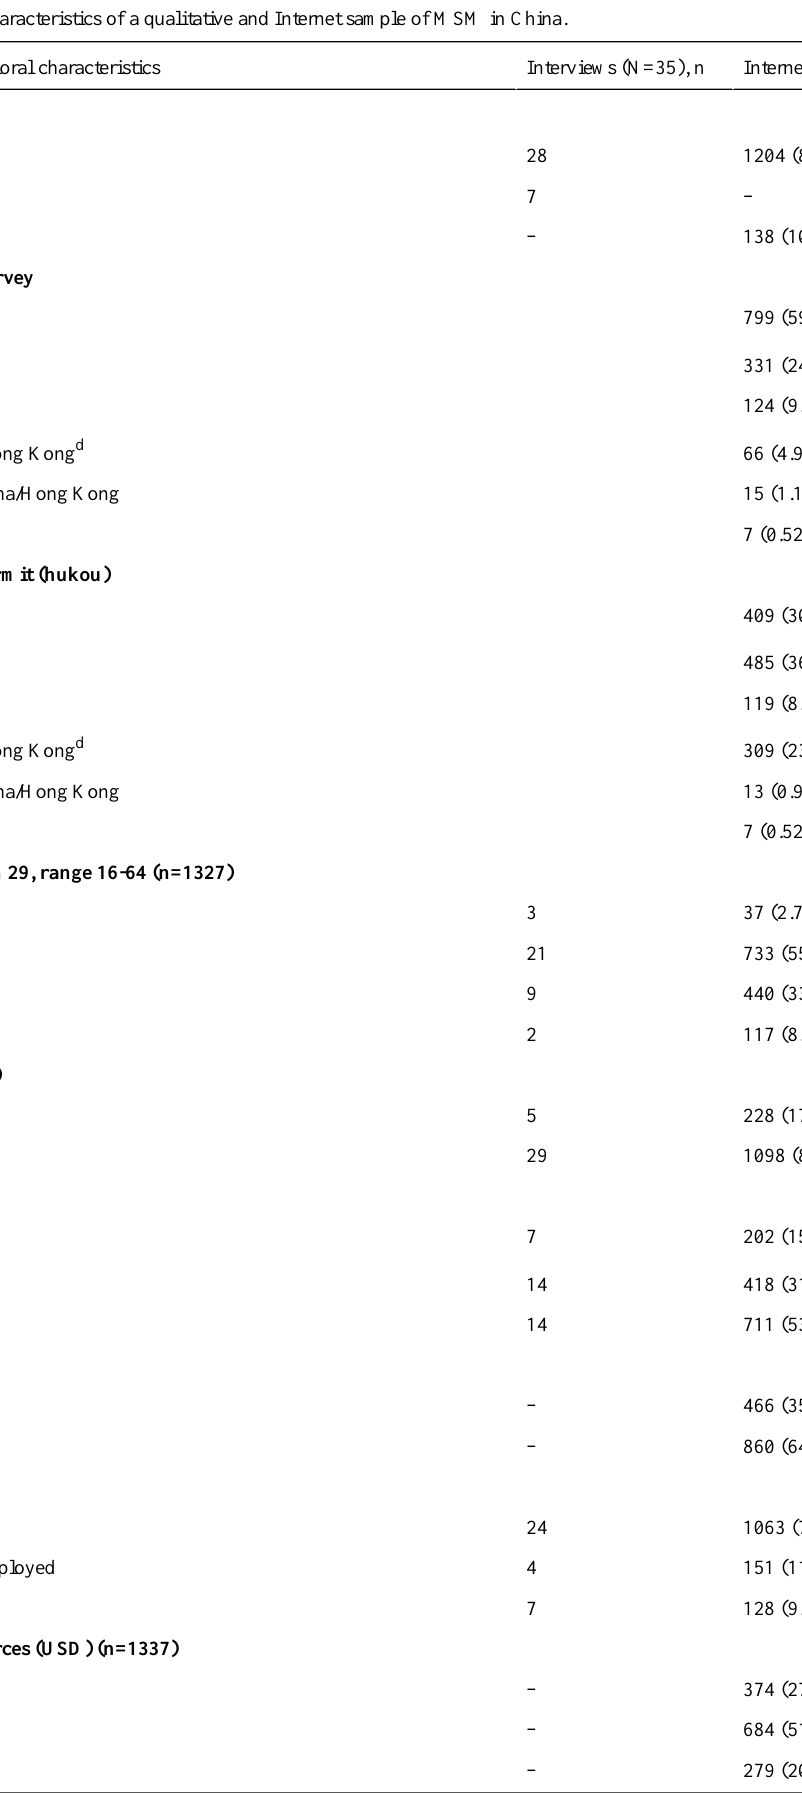
Table 1. Demographic characteristics of a qualitative and Internet sample of MSM in